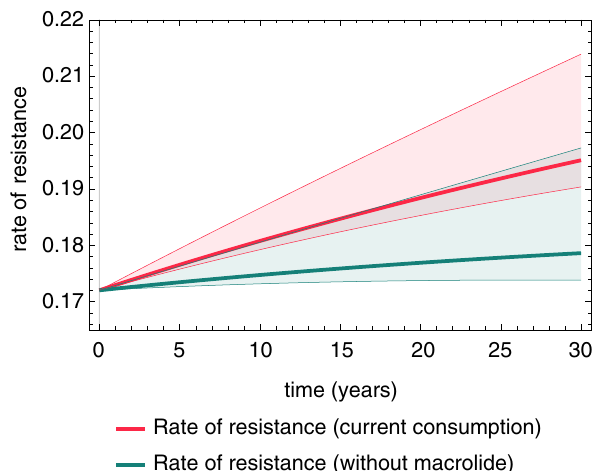
Fig. 4 Modeling the future prevalence of H. pylori clarithromycin resistance with and without non-eradication-purpose macrolide use in the population. The model shows a noticeably slower long-term growth rate of Cla-res prevalence among infected individuals with the discontinuation of non-eradication-purpose macrolide use (green line) than with the current situation (with a constant level of macrolide consumption), in which the model predicts a more rapidly increasing rate of Cla-res infections (red line). Cla = clarithromycin, res = resistance/resistant, H. pylori = Helicobacter pylori